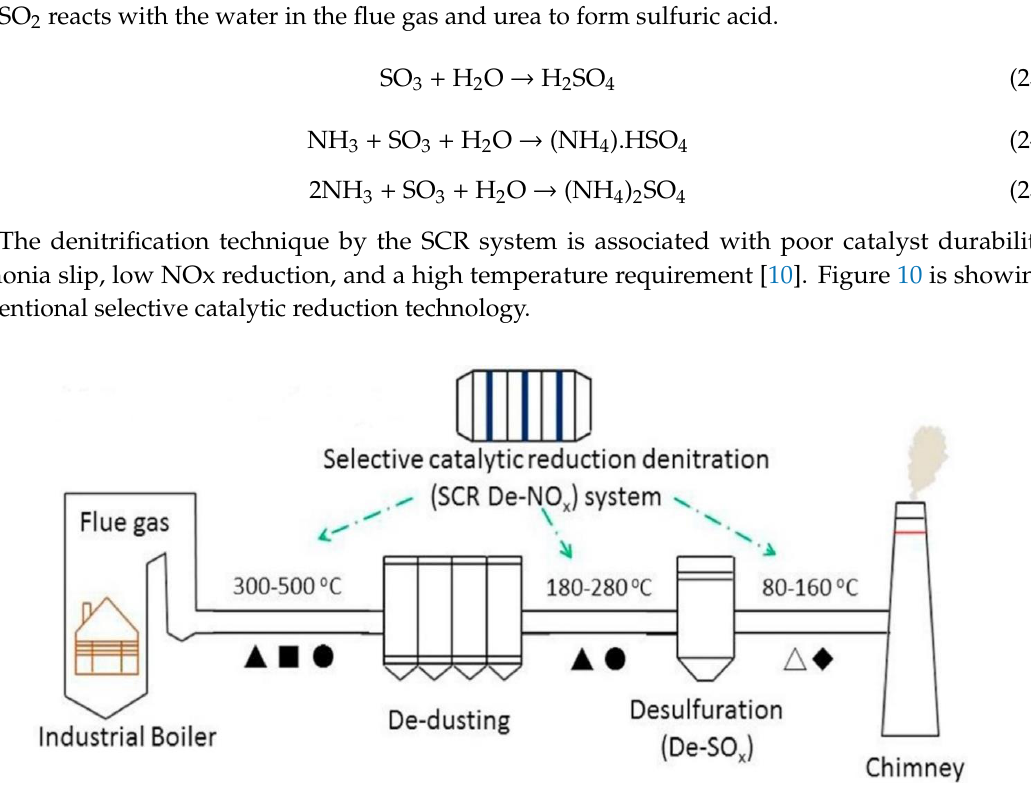
Figure 10. Conventional selective catalytic reduction technology. Reproduced with permission from